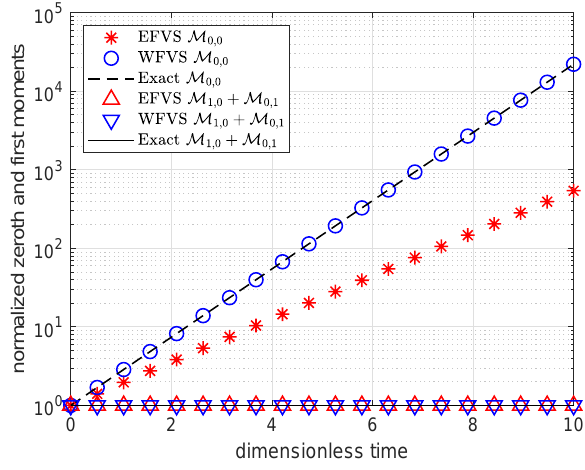
( a ) Zeroth- and first-order moments. Figure 1. Cont